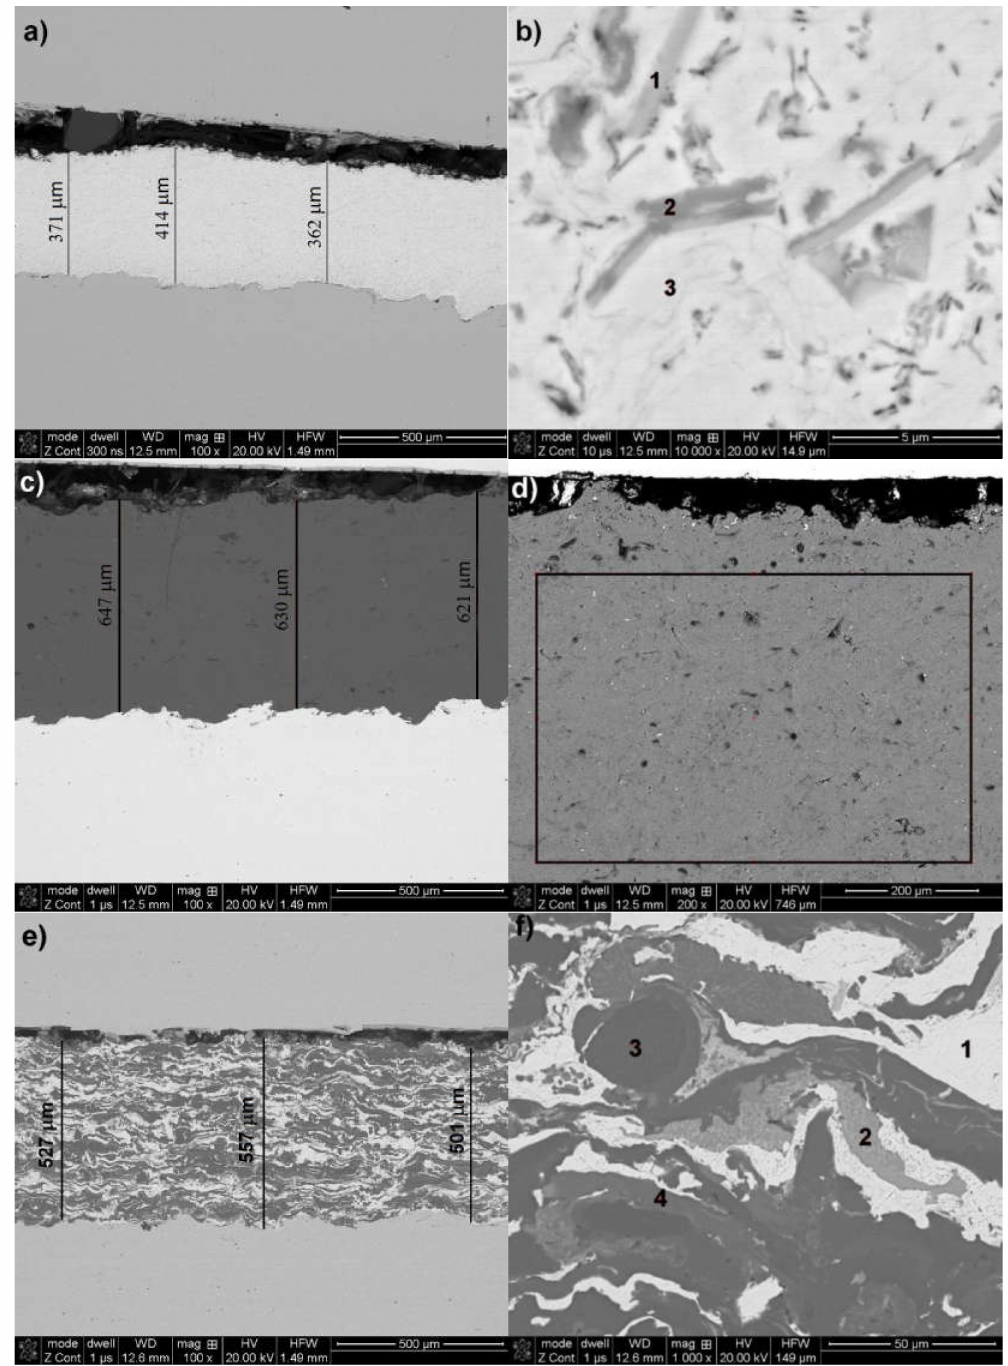
Figure 1. A typical microstructure of Zn ( a , b ), Al ( c , d ), and Zn-Al ( e , f ) arc-wire sprayed coatings exhibiting type and grains morphology with chemical composition based on point ( b , f ) and area ( d ) SEM/EDS